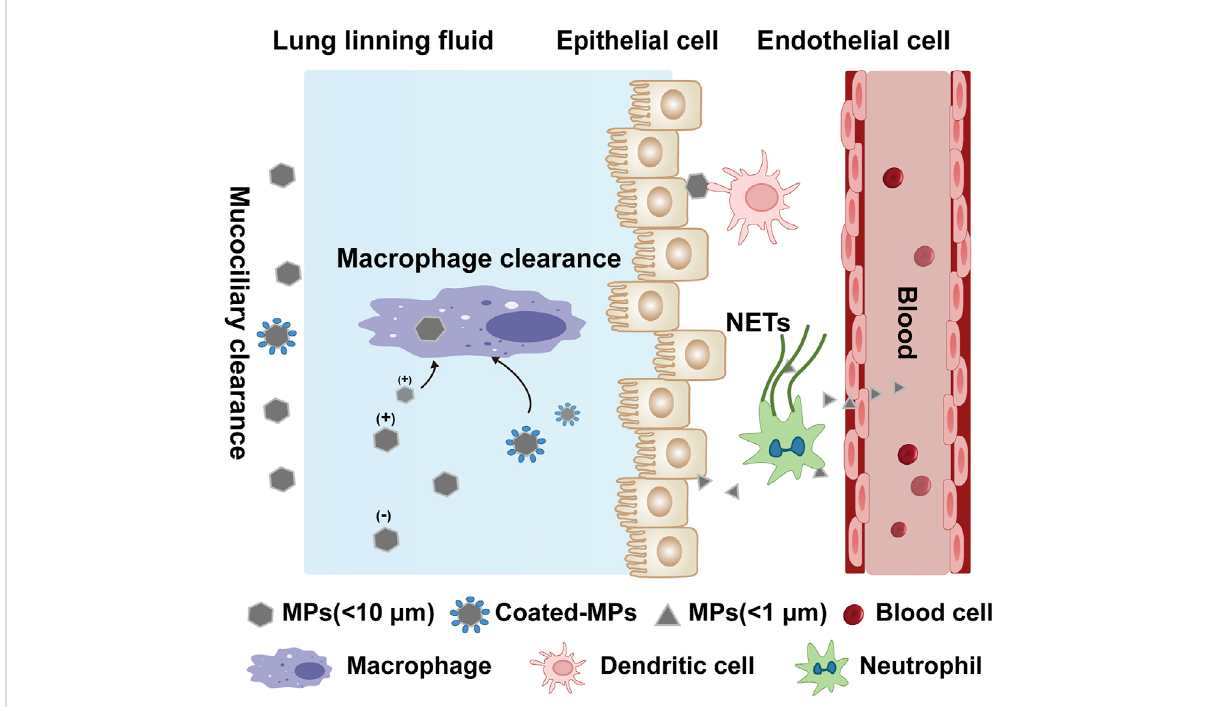
FIGURE 2 Potential internalization and clearance mechanisms of microplastics in the lungs. The lung lining fl uid (surfactant and mucus) reduces the chanceofmicroplasticdisplacement.Particles < 10 μ mareclearedbymucociliary,whileparticles < 1 μ mareuptakenthroughtheepitheliumandalso may penetrate the thin lung lining fl uid and contact the epithelium, and circulate and metastasize through diffusion or active cellular uptake. The surface charge and surface-molecular interactions of different MPs affect the immune cell clearance. For macrophage, positive charged MPs and coated-MPs (combined with protein or other substances) are more likely to interact with the cell membrane. Other immune cells are also involvedinthedefensesagainstMPs,suchasantigenpresentationbydendriticcellsandthetrappingandphagocytosisofMPsthroughthereleaseof NETs by neutrophils, causing immune